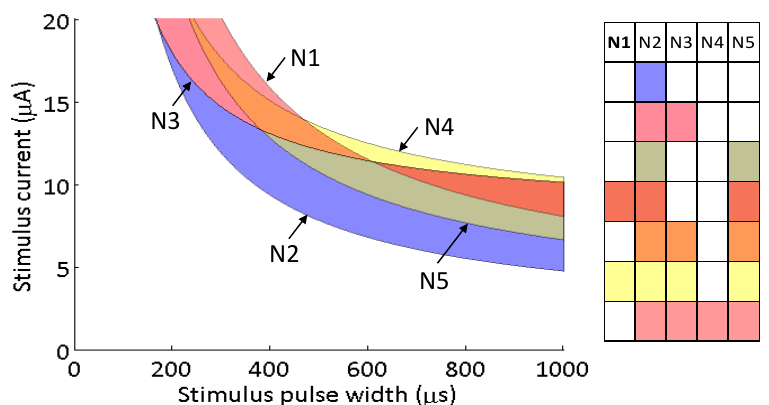
Figure 7. A map of selectivity regions accessible using one stimulating electrode. The strength–duration curves associated with P = 0.5 are plotted for each of the five neurons, and the regions in between the curves are color coded to define the population that is activated within that waveform region.